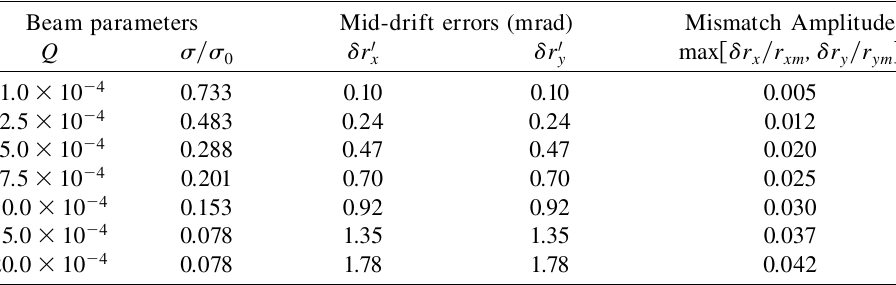
INFLUENCE OF CONDUCTING PLATE BOUNDARY . . TABLE III. Maximum envelope mismatch excursions seeded from errors associated with intercepting beam diagnostics in a periodic alternating gradient transport lattice describing (cid:1) " (cid:1) 50 mm mrad , " (cid:1) 80 (cid:20) , and a 70 mm axial the HCX experiment. Results are for " x y 0 drift from the plate to a midquadrupole drift location. Beam parameters